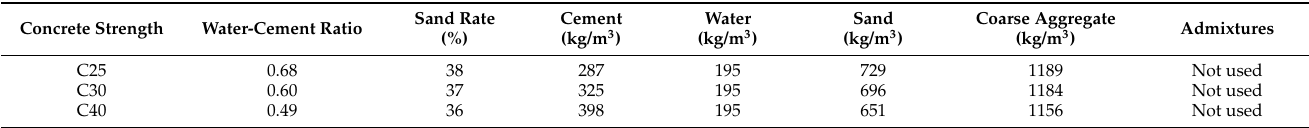
Table 7. Concrete mix ratio